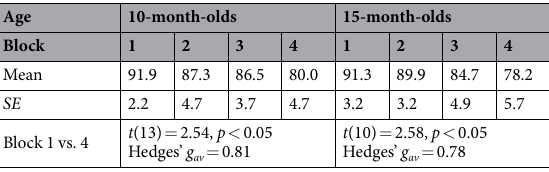
Table 1. Proportion of looking time (%) during the familiarization phase.